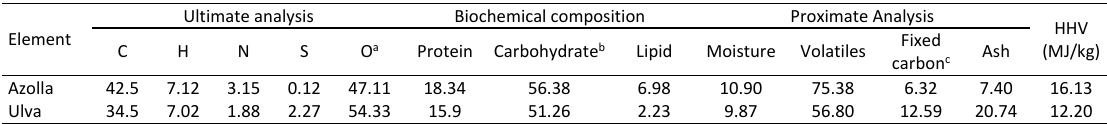
Table 1: Chemical composition and ultimate and proximate analyses of A. filiculoides and U. fasciata biomass samples Element